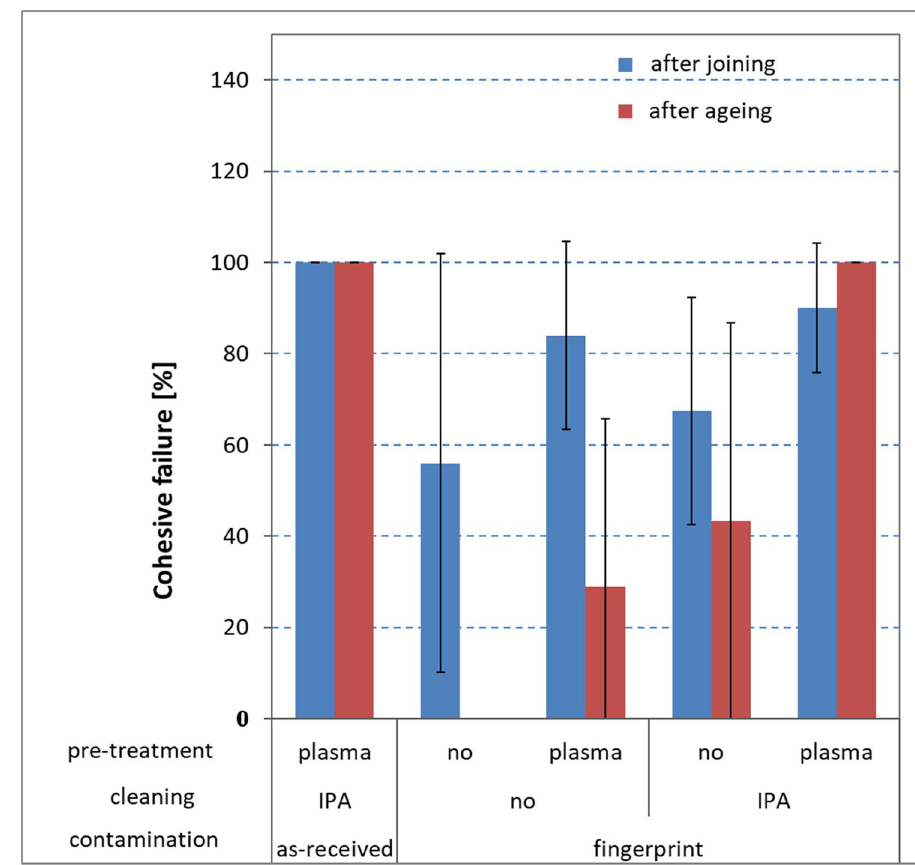
Fig. 5 Comparison of fracture surface composition results obtained for aged (red col- umns) and non-aged (blue columns) lap shear samples for different sample sets pre- pared from green ABS-PMMA adherends with a fingerprint as a surface contamination in the bonding region. Different starting states of the adherend surfaces, optionally applying a cleaning step with isopropanol (IPA) and optionally perform- ing surface pre-treatment with atmospheric pressure plasma (APP) treatment are